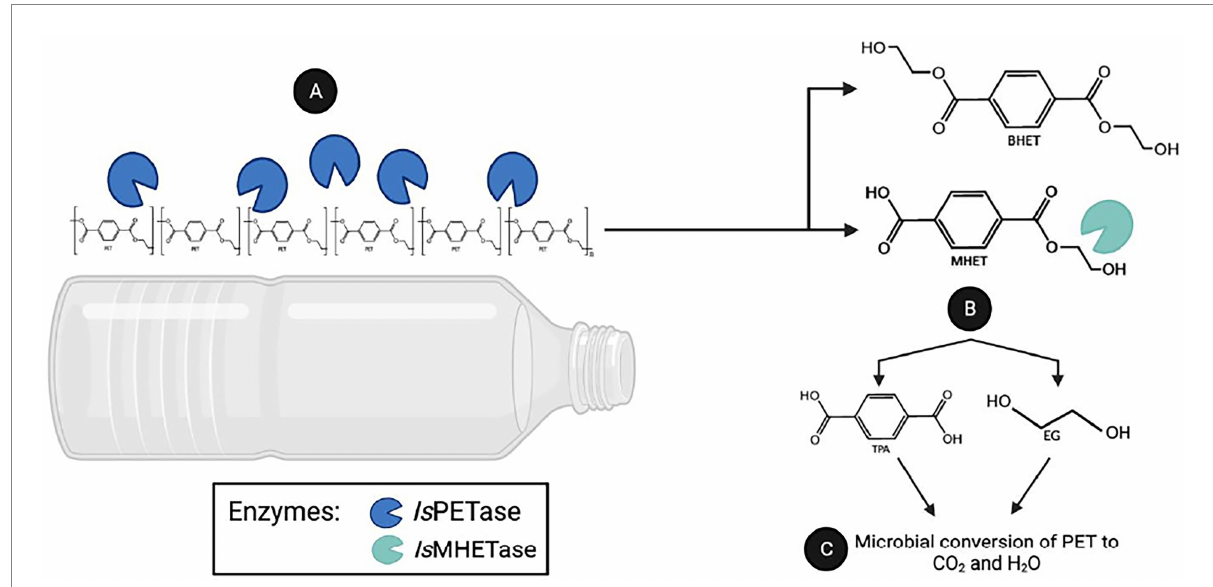
FIGURE 1 PET degradation by the enzymes PETase and MHETase. The Gram-negative bacterium I. sakaiensis 201-F6 is able to produce Is PETase and Is MHETase enzymes. (A) The Is PETase degrads polythylene chain producing bis(2-hydroxyethyl)terephthalate(BHET) or mono(2-hydroxyethyl) terepththalate(MHET). (B) While Is MHETase are converting MHET to non-toxic compounds: terephthalic acid and ethylene glycol. (C) By assimilation, these molecules converted to a carbon dioxide as byproduct of microbial conversion of